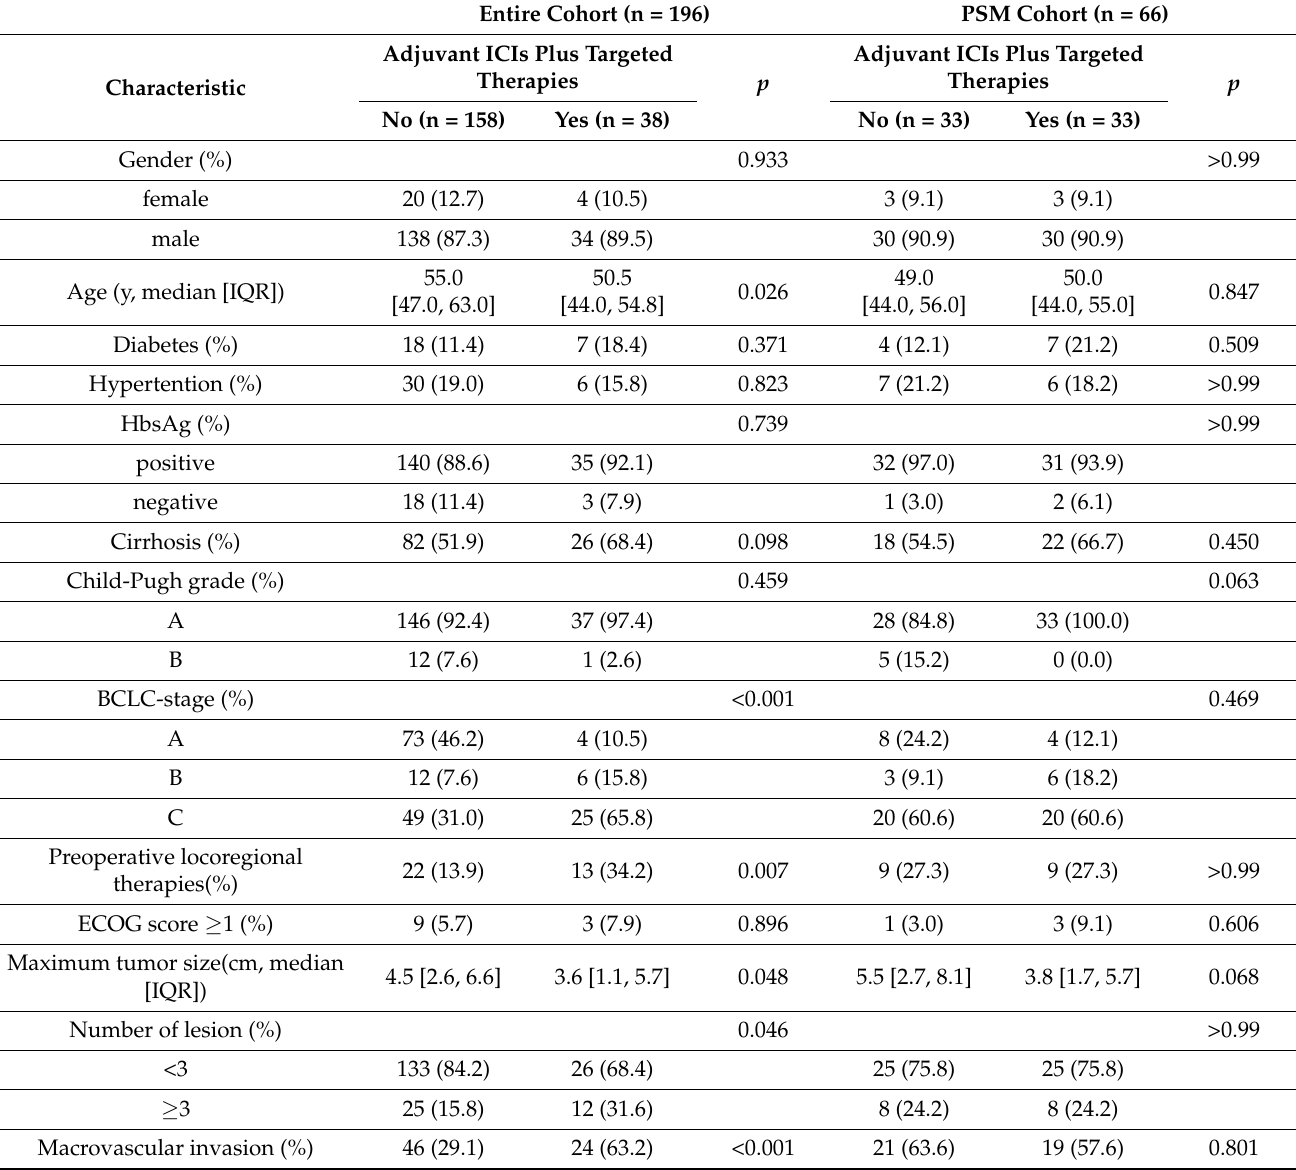
Table 2. Baseline characteristics of control and treatment group in entire cohort and propensity-score- matched (PSM) cohort. Entire Cohort (n = 196) PSM Cohort (n =